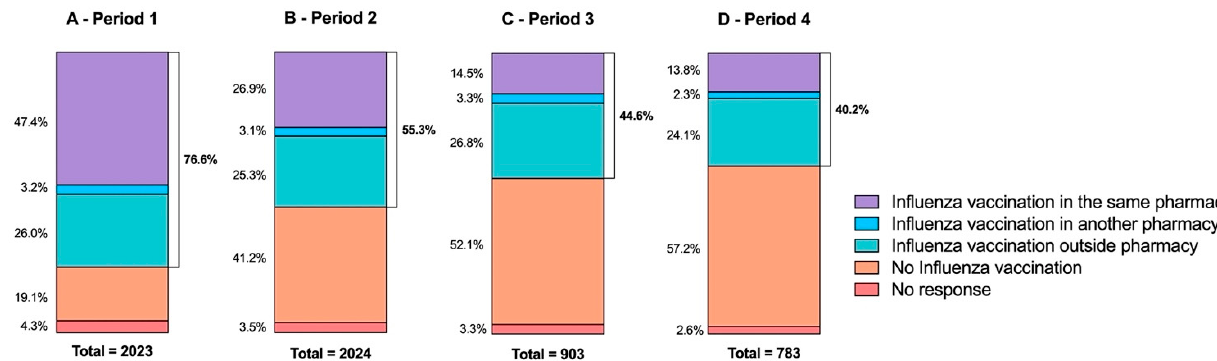
Figure 3. Previous influenza vaccination of respondents depending on survey period (A—period 1, from 16 March to 10 April; B—period 2, from 11 April to 30 April; C—period 3, from 1 May to 30 May; D—period 4 from 31 May to 30 June). *Vaccination against influenza is recommended for the most vulnerable individuals (people aged 65 and over, pregnant women, people with certain chronic conditions, and obese people with a body mass index greater than or equal to 40) [20].